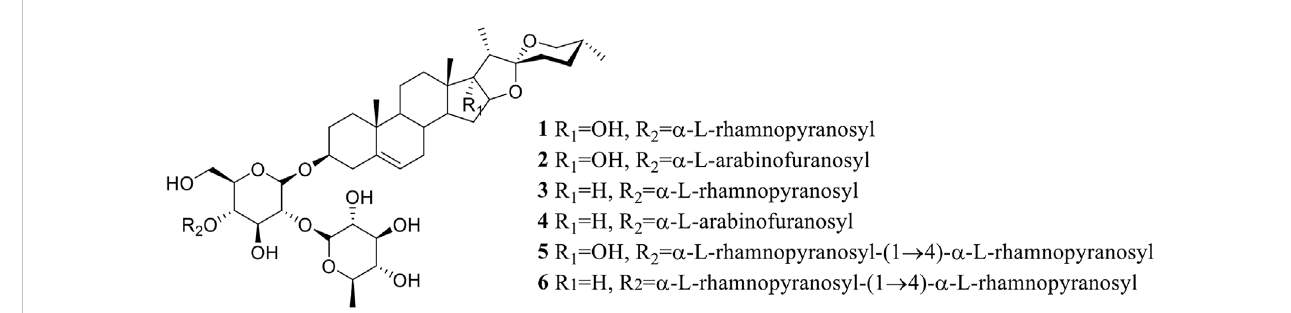
FIGURE 1 Structure of saponins 1 – 6 extracted from P. polyphylla var. yunnanensis